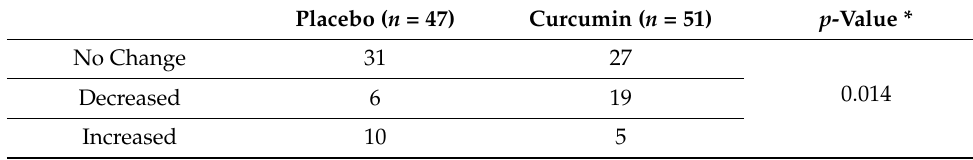
Table 5. Change in pain-relieving medication at week 8 compared to baseline.